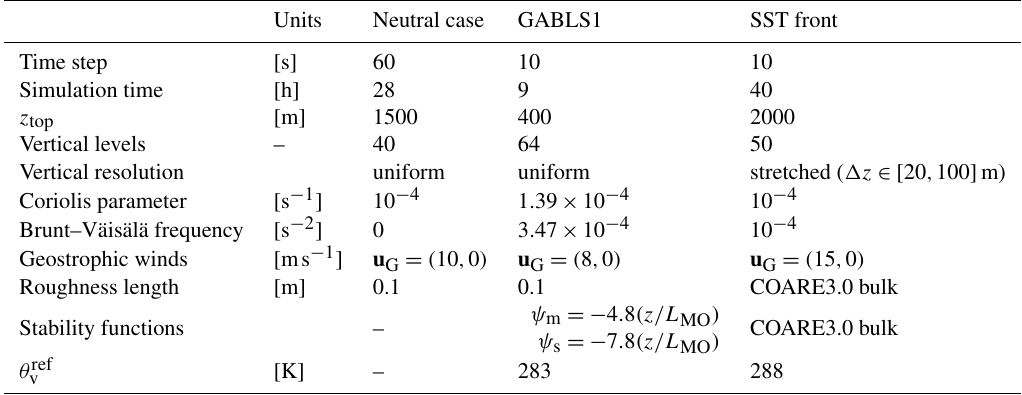
Table 2. Description of the idealized experiments performed in Sect. 4. L MO is the Monin–Obukhov length. Units Neutral case